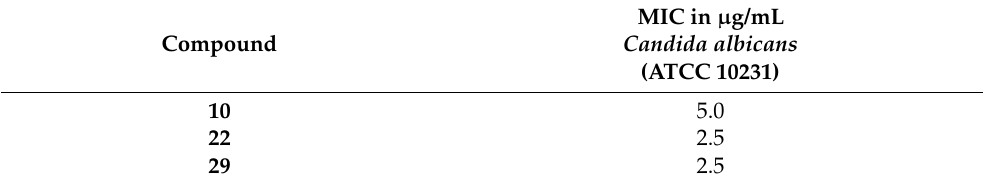
Table 3. Antifungal activity of compounds 10 , 22 and 29 in lower concentrations.